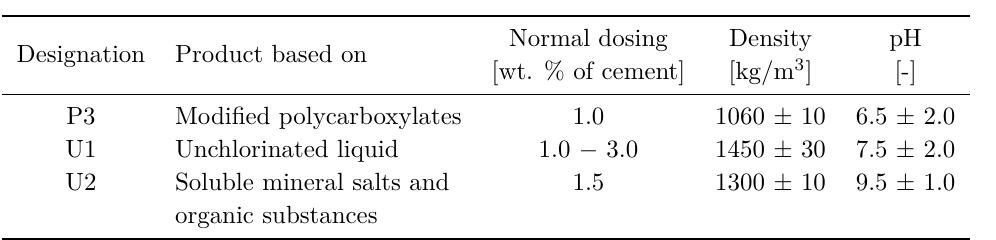
Table 1. Selected additives and its properties.